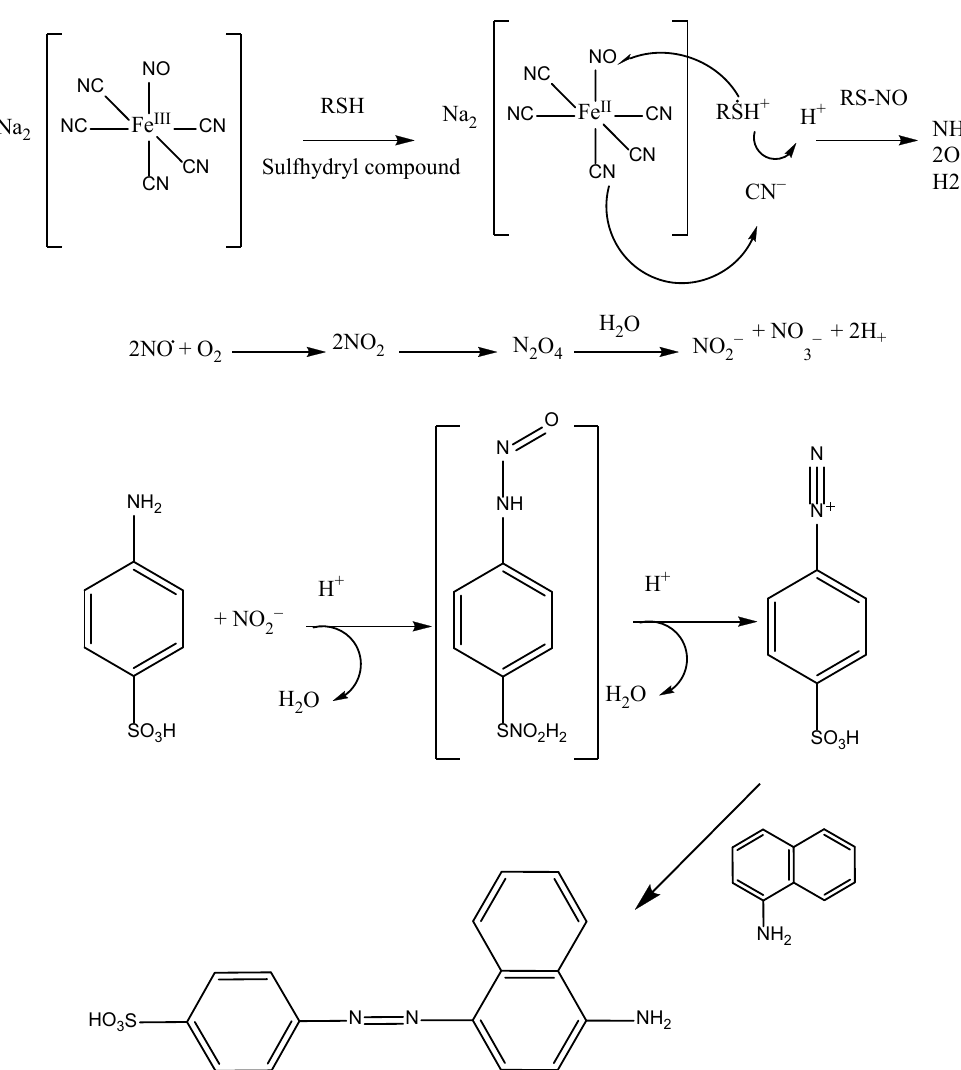
Figure 18. Mechanism reaction of how NO free radicals are scavenged by Griess reagent [58].